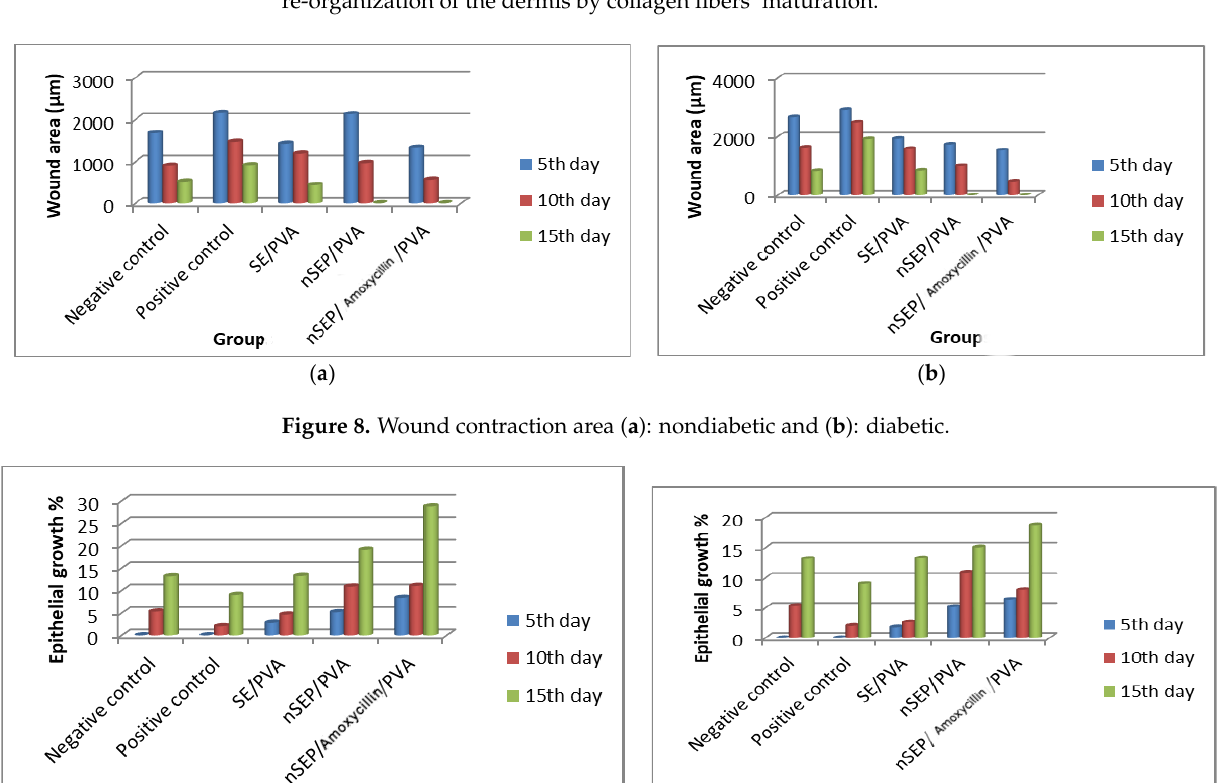
Figure 7. The histological evaluation of skin wounds at different time intervals (5th, 10th, 15th day) indicated regression of the lesions with better epithelialization (blue arrows) and more effective re-organization of the dermis by collagen fibers’ maturation.